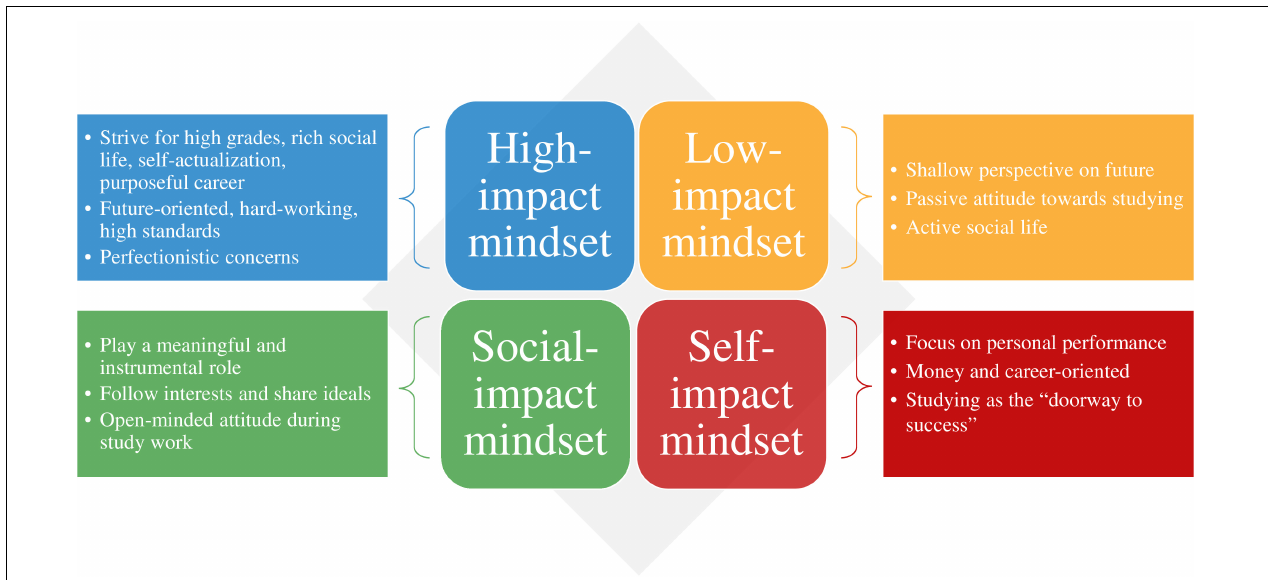
FIGURE 2 | Characterizations of the four motivational